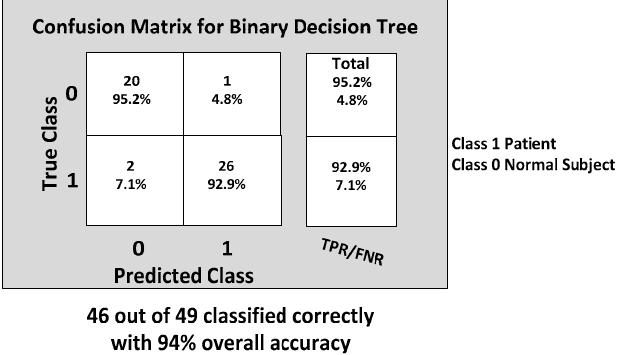
feature space: Case 7 (DGI 7) of the first normal subject, Case 4 (DGI 4) of the fourth patient and Case 6 (DGI 6) of the first patient.